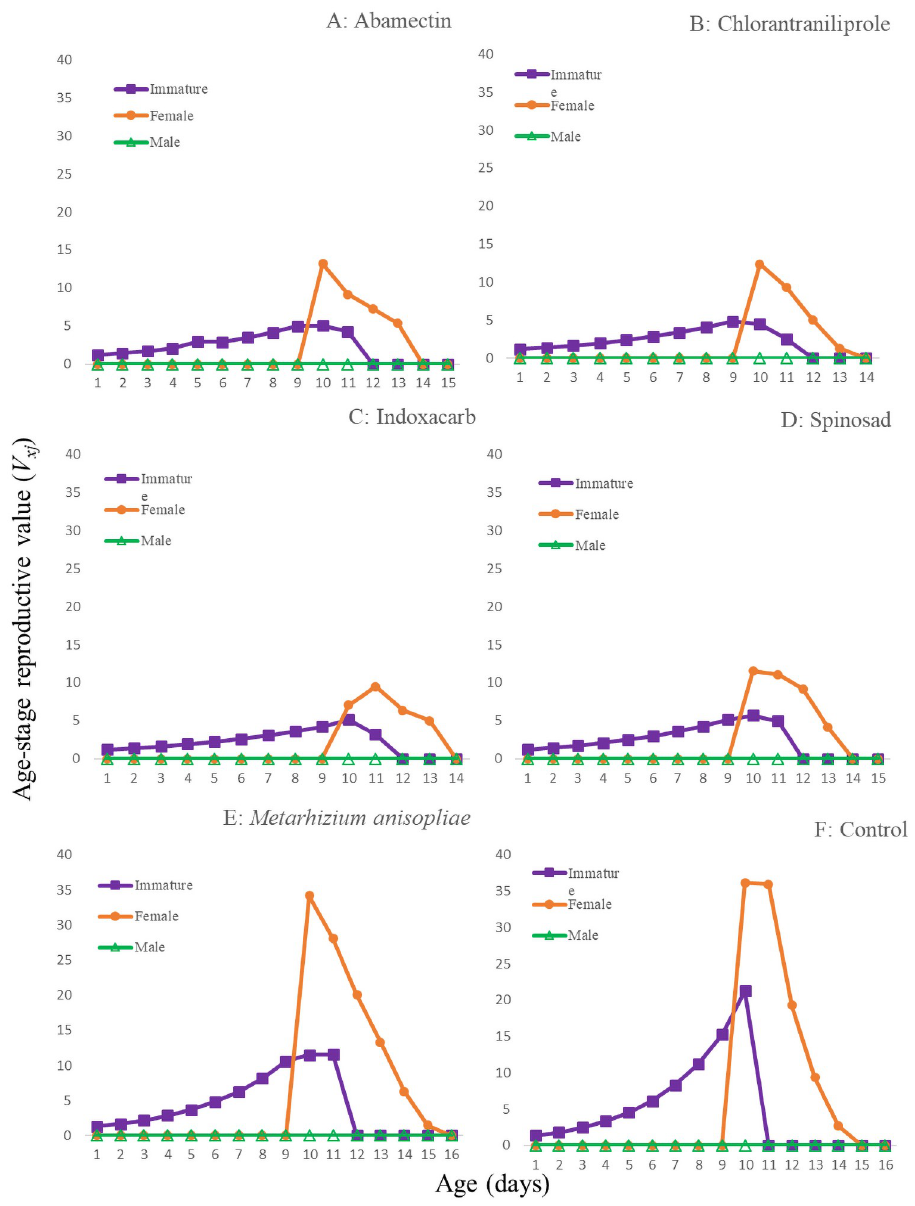
Fig 4. Age-stage reproductive value ( V xj ) of the T . brassicae exposed to different pesticides 48 hours after spraying, A: Abamectin, B: Chlorantraniliprole, C: Indoxacarb, D: Spinosad, E: M . anisopliae , F: